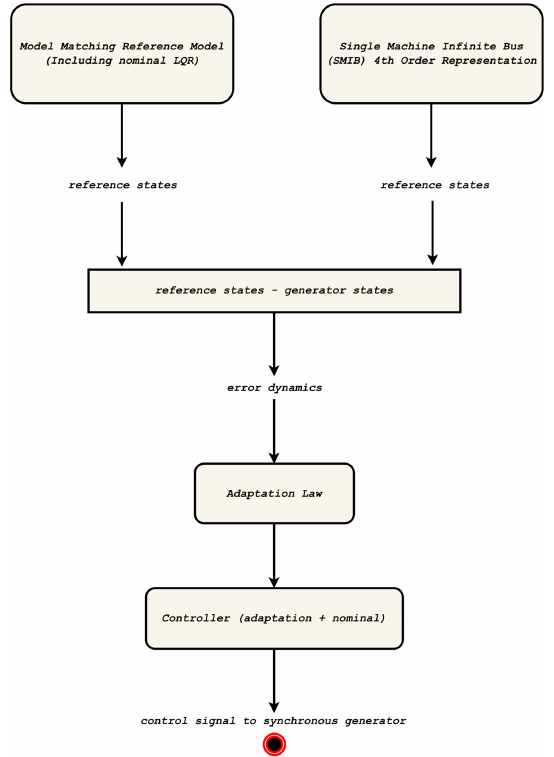
Figure 3. MRAC architecture for rotor angle stability enhancement.